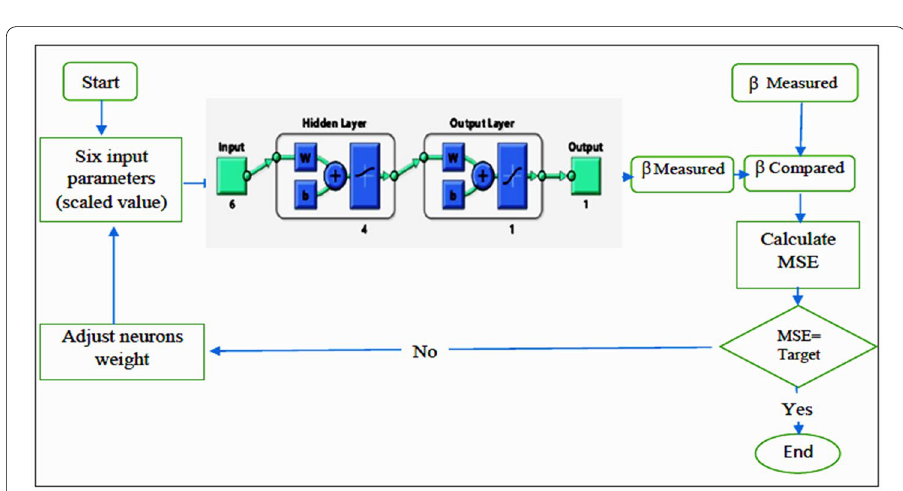
Fig. 2 Flow chart algorithm and structure of ANN for predicting max. Wall